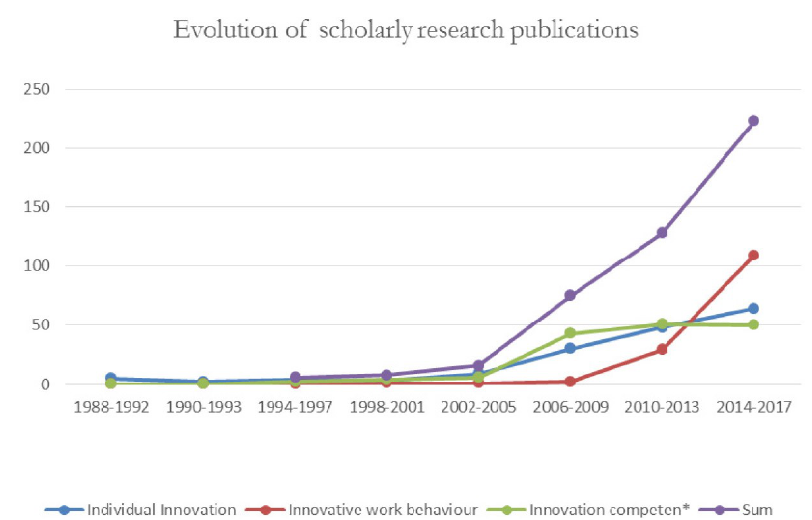
Figure 1. “Individual Innovation”, 165 hits; “Innovative Work Behaviour” (IWB), 142 hits;